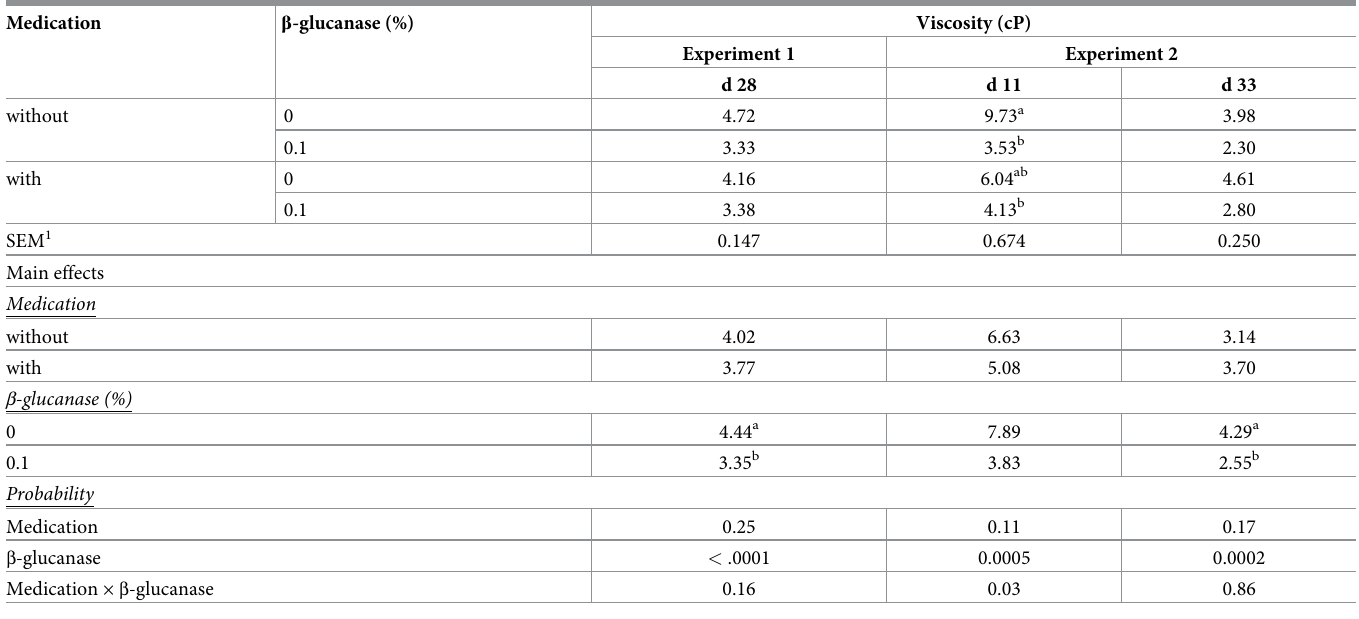
Table 3. Effects of diet medication and β -glucanase on the viscosity of ileal supernatant in broiler chickens. Medication